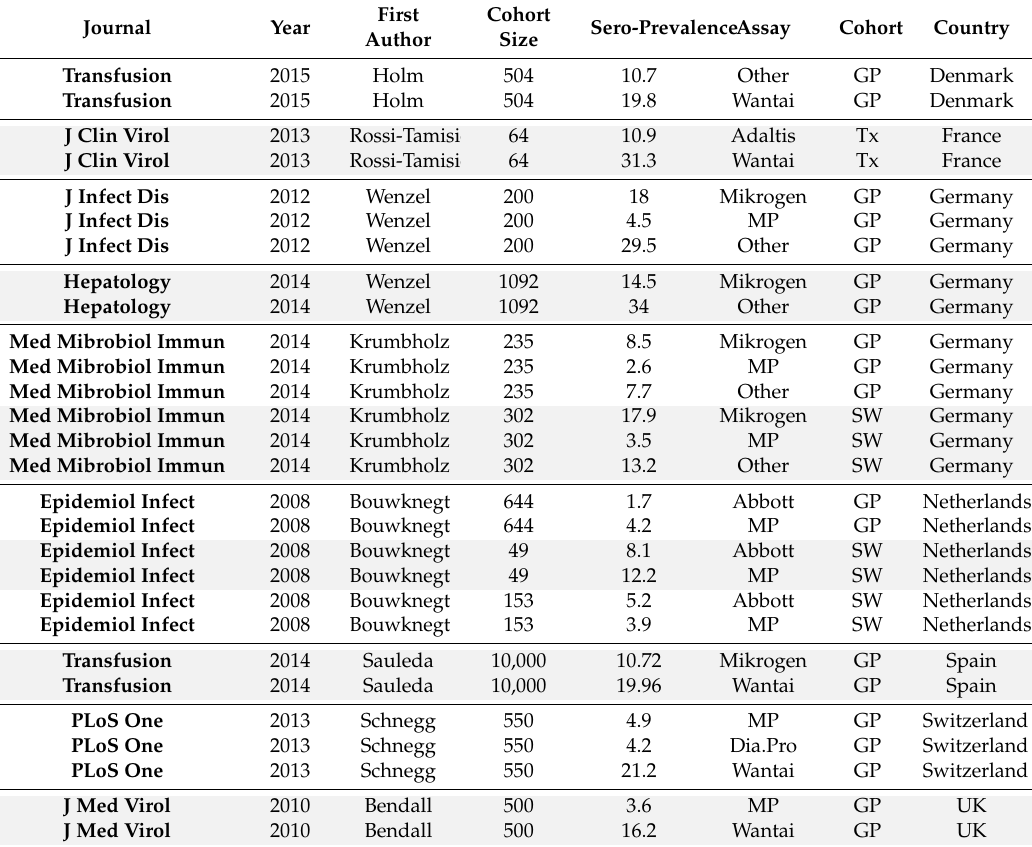
Figure 2. The relationship between anti-HEV IgG seroprevalence rates and the assay employed in different study cohorts. The difference between Wantai (WT) vs. Mikrogen (MG) and WT vs. MP was statistically significant after adjusting for study cohort (WT vs. MG: p < 0.05; WT vs. MP: p < 0.001). Table 2. Studies assessing anti-HEV IgG seroprevalence in a given population by different anti HEV-IgG assays (n = 9).